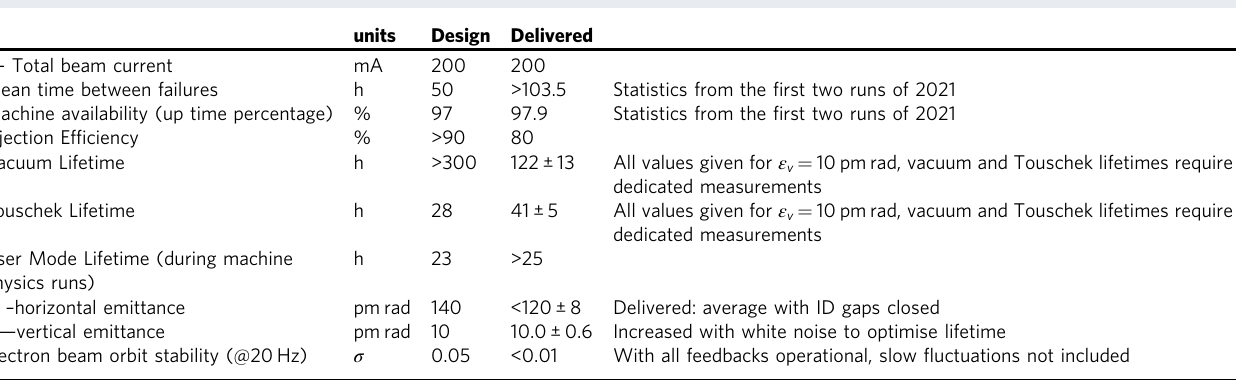
Fig. 3 Main milestones of the ESRF-EBS machine commissioning. The fi gure shows the main milestones for the EBS commissioning from November 2019 when commissioning started, until May 2019 when beam was given for fi rst user activities. Table 2 Design goals and delivered parameters in USM condition and uniform